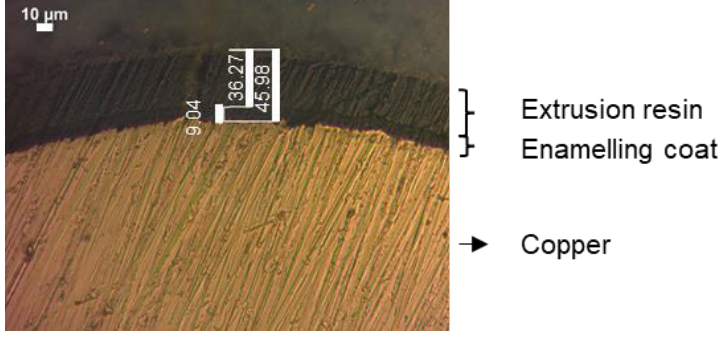
Figure 8. Microscopic view of insulated wire (dimensions in µm).